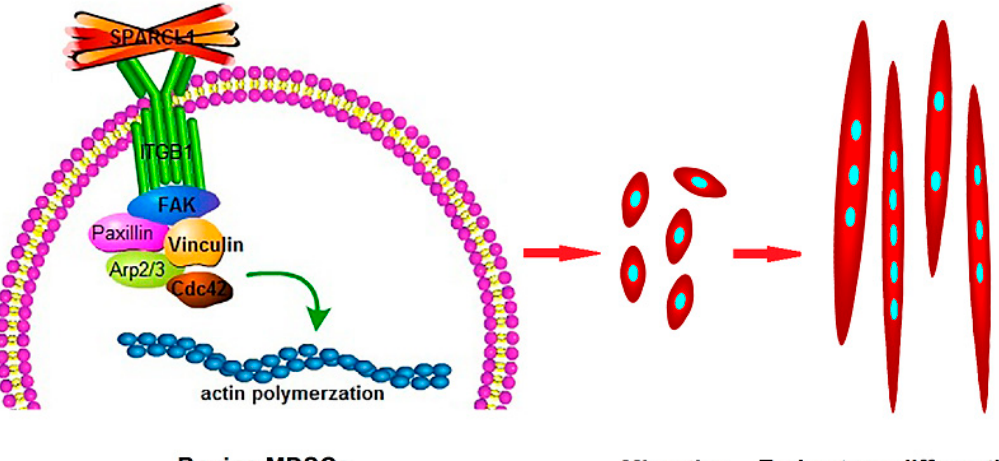
Figure 8. Proposed model for SPARCL1 regulation of bovine MDSC migration and di ff erentiation through ITGB1. As an extracellular matrix protein, SPARCL1 interacts with the transmembrane receptor ITGB1 and regulates changes in the expression of adhesion-plaque-associated proteins, such as ITGB1, p-FAK, FAK, p-paxillin, paxillin, and vinculin to a ff ect the formation of focal adhesions. The Cdc42 and Arp2 / 3 complex was also a ff ected by SPARCL1 through ITGB1. Further, bovine MDSC migration was stimulated by SPARCL1, and cells gathered and apparently expressed MyoD to begin an early-stage di ff erentiation.